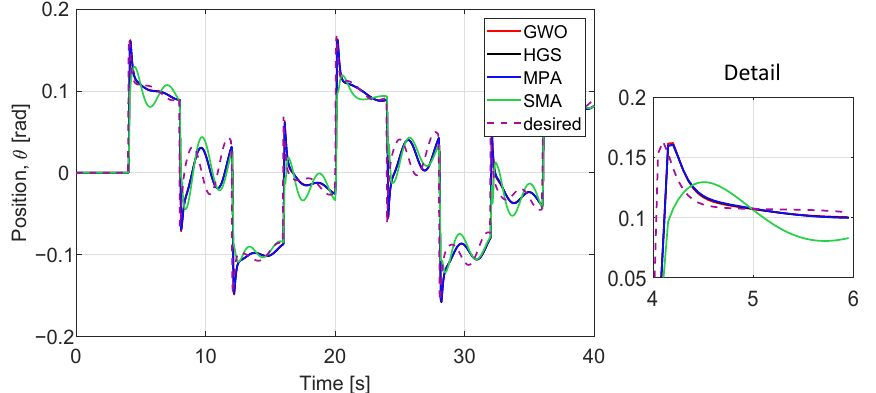
Figure 20. Comparison of tracking performance in θ –angle of the different algorithms evaluating the parameters obtained with 100 individuals.